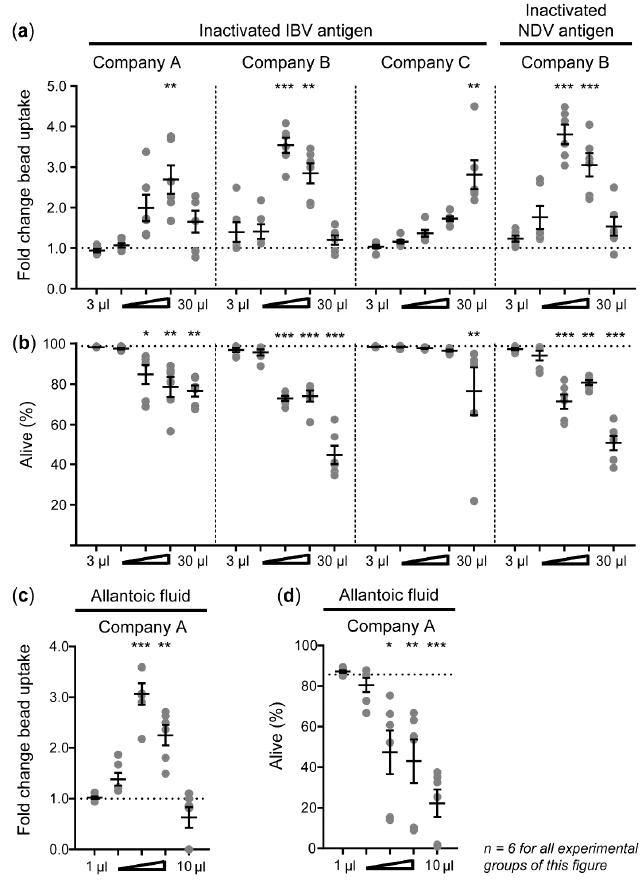
Figure 3. Phagocytosis of IgY-opsonized beads by HD11 cells is increased upon exposure to inactivated IBV and NDV antigens. ( a ) Differences in bead uptake upon exposure to IBV and NDV antigens are expressed as fold changes compared to unstimulated